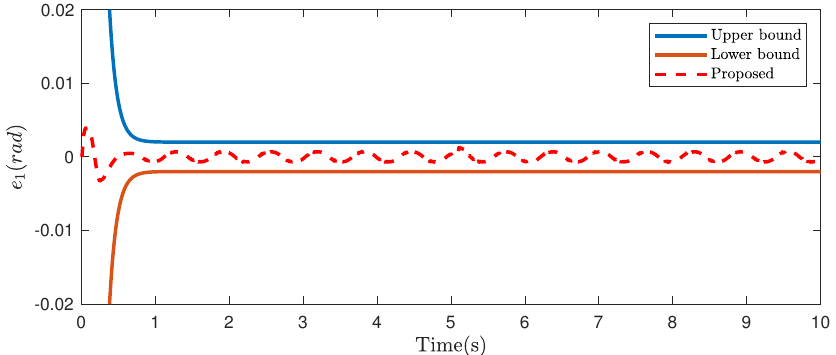
Figure 6. Tracking performance of the suggested controller in case of step reference trajectory.